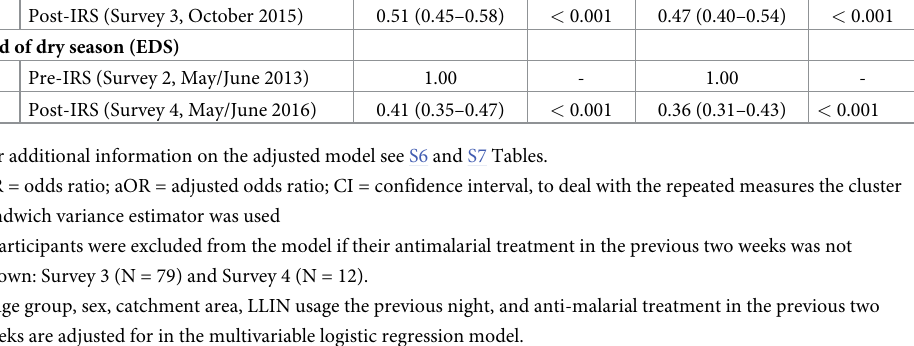
Microscopic P . falciparum infection a Unadjusted Adjusted b OR (95% CI) p-value aOR (95%